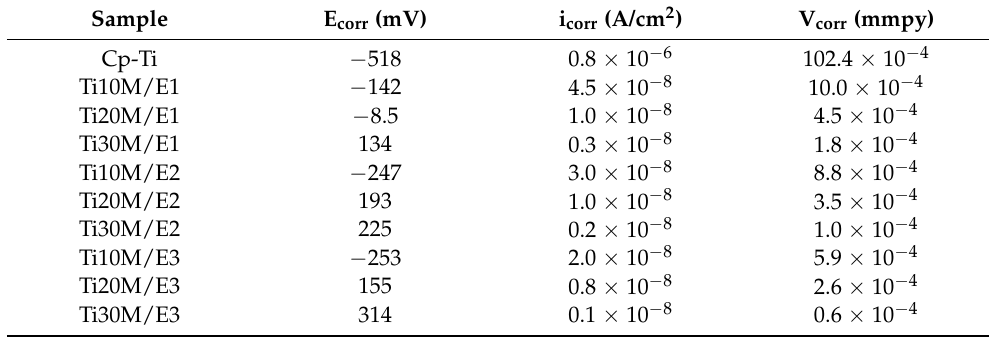
Table 3. Results of potentiodynamic polarization tests in 3.5 wt.% NaCl solution at room